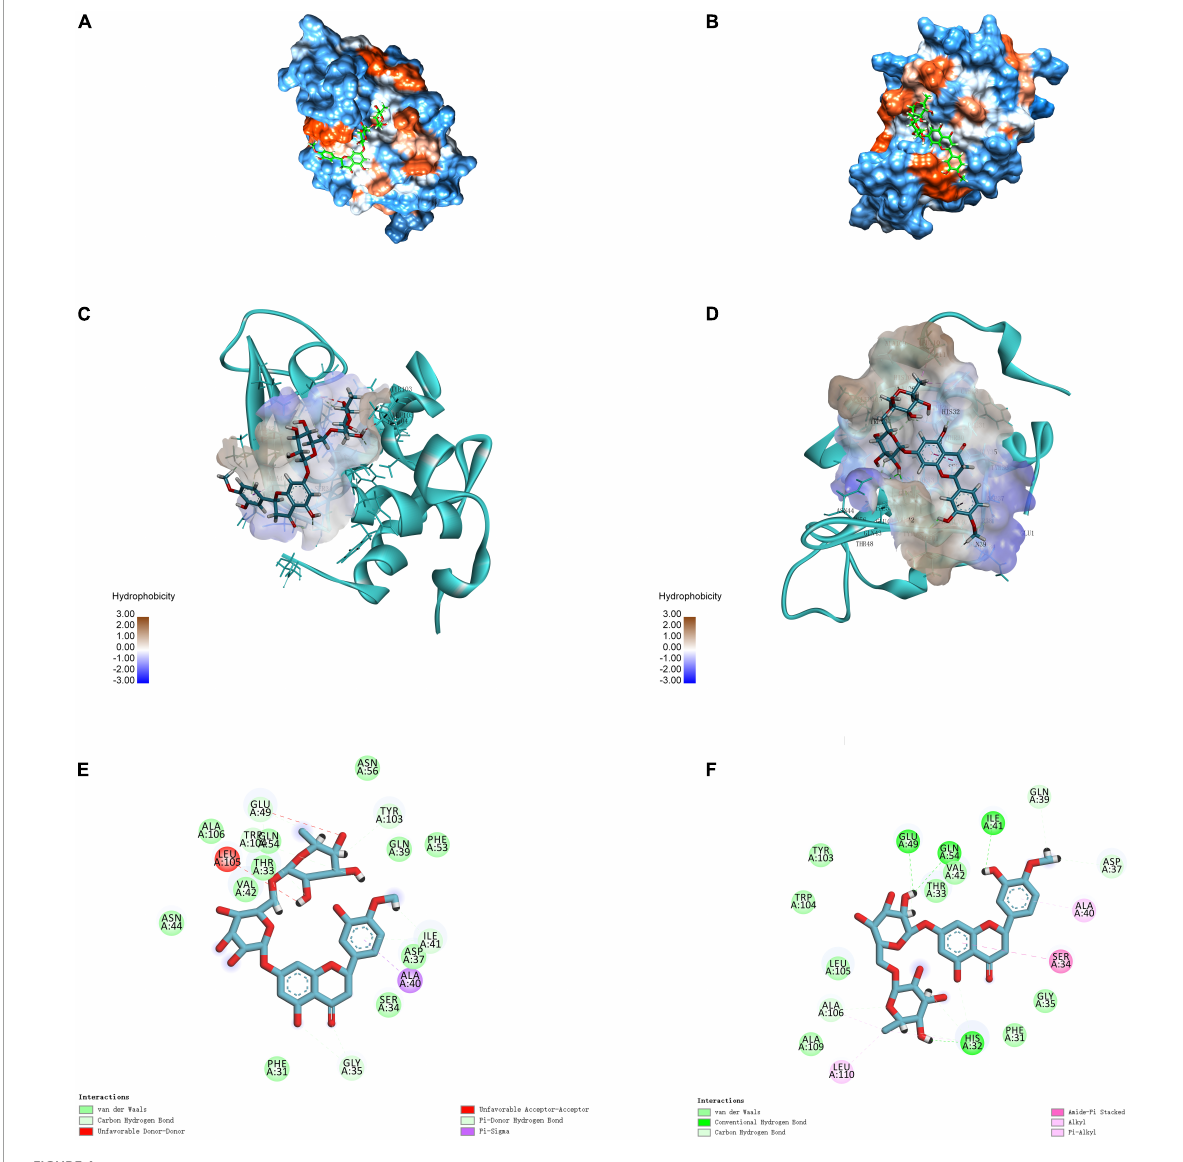
FIGURE4 3D diagrams of α -LA-HES (A) and β -LG-HES (B) ; the hydrophobicity surface of α -LA (C) and β -LG (D) interacted with HES, the red color and blue color represent hydrophobicity and hydrophilicity, respectively; 2D schematic interaction diagram α -LA-HES (E) and β -LG-HES (F) , the color of amino acid residue is drawn by